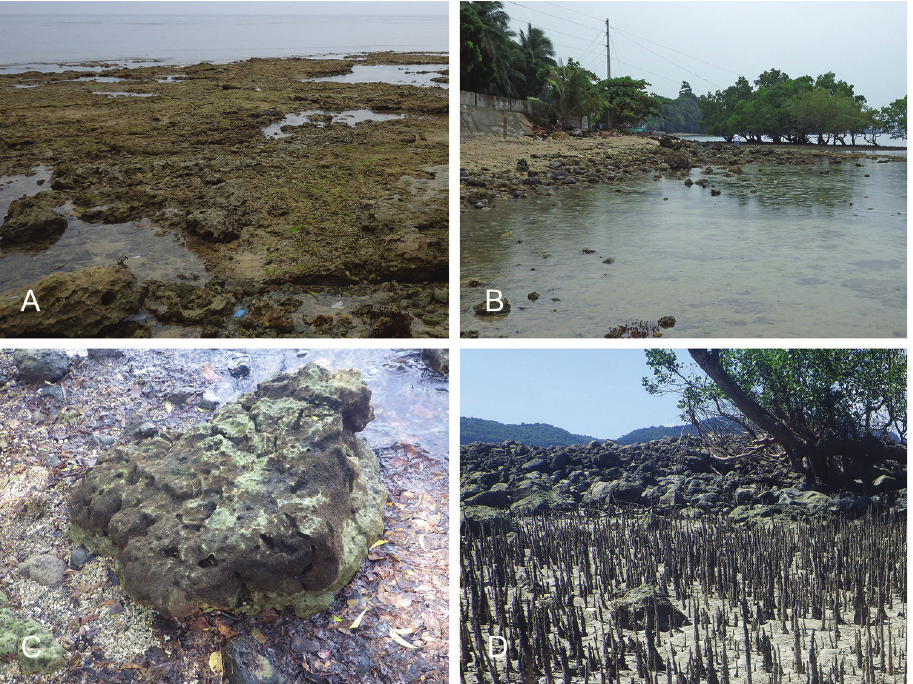
Figure 54. Habitats, Wallaconchis comendadori . A Type locality, Philippines, Bohol, Guindulman, rocks and coral rubble near a few Avicennia trees (st 197) B View of the shore (same locality as A) C Indonesia, Bali, Pemuteran, Labuhan Lalang Harbor, coral rubble, rocks and a few Avicennia trees (st 157) D Indo- nesia, Lombok, Don Don, old Avicennia forest, with coral rubble (st